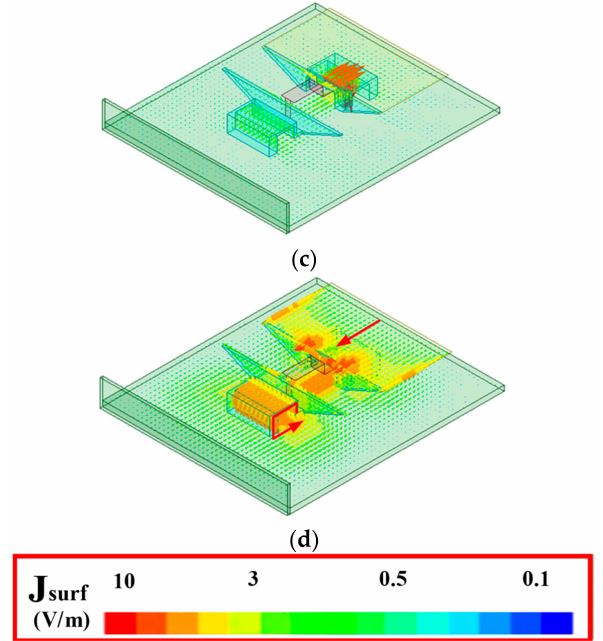
Figure 7. The distribution of electric current in one period. ( a ) at t = 0, ( b ) at t = T/4, ( c ) at t = T/2, ( d ) at t = 3T/4.